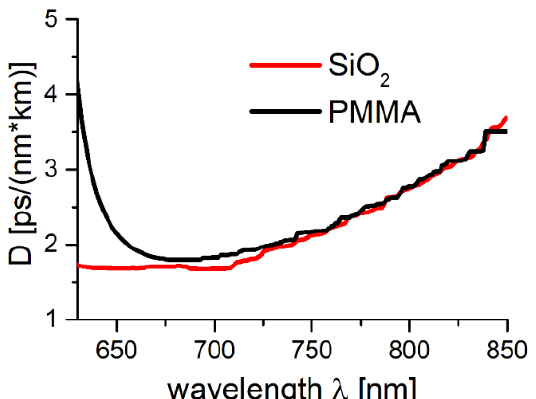
Figure 13. Dispersion parameter spectrum for the star structure made of PMMA and silica glass (SiO 2 ). For the spectral range of ~675 to 800 nm, both dispersion curves are almost identical. As a result, both fibers can be considered suitable for ultrashort light pulse delivery.